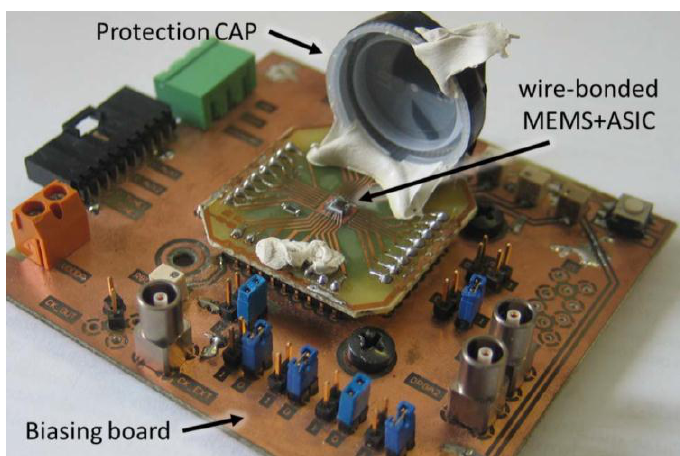
Figure 29. Photography showing the staked MEMS and ASIC dies, which are wire-bonded on a socket carrier located on the biasing PCB board [47]. Reprinted with permission from [47].